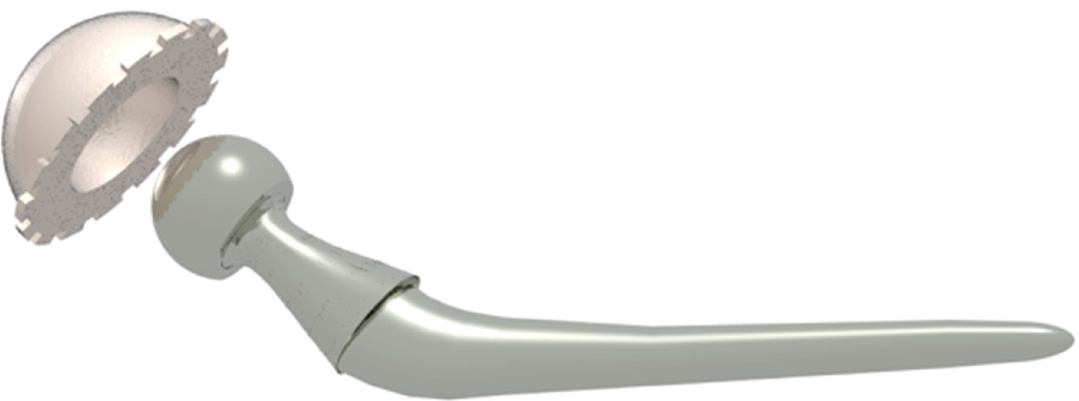
Figure 2. Charnley’s first LFA.